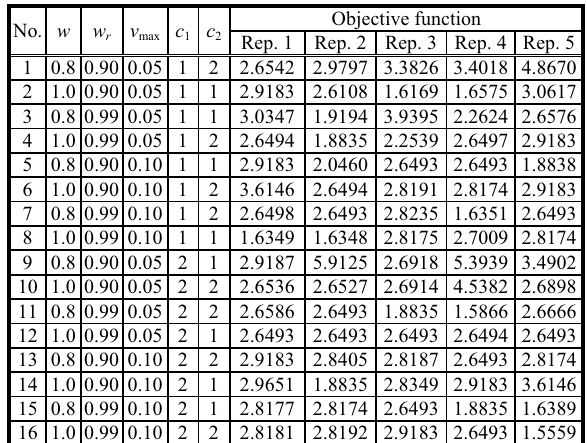
Table 7. Experiment on PSO parameters.